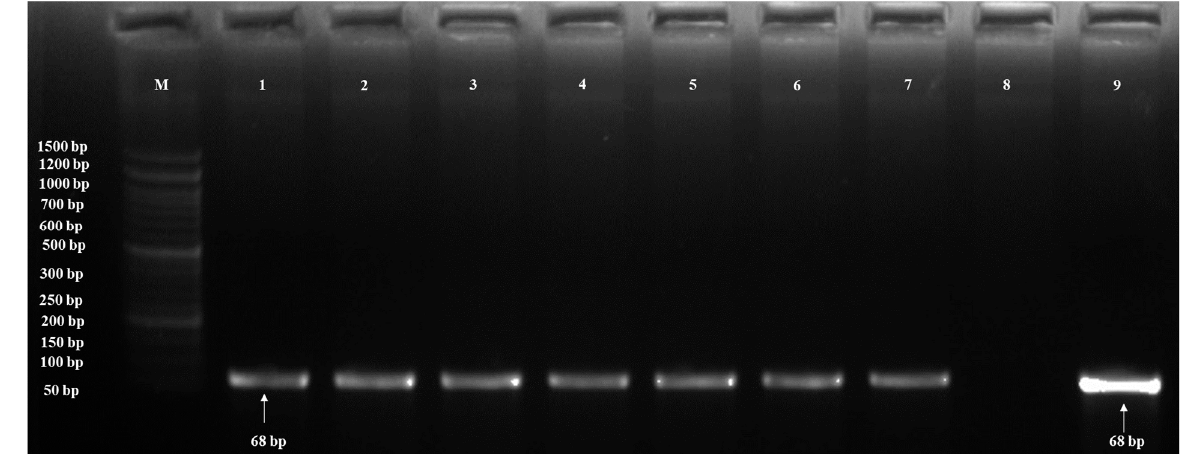
Figure 4. ( a ) Agarose gel electrophoresis showing PCR amplification of TPS1 gene for acid tolerance.